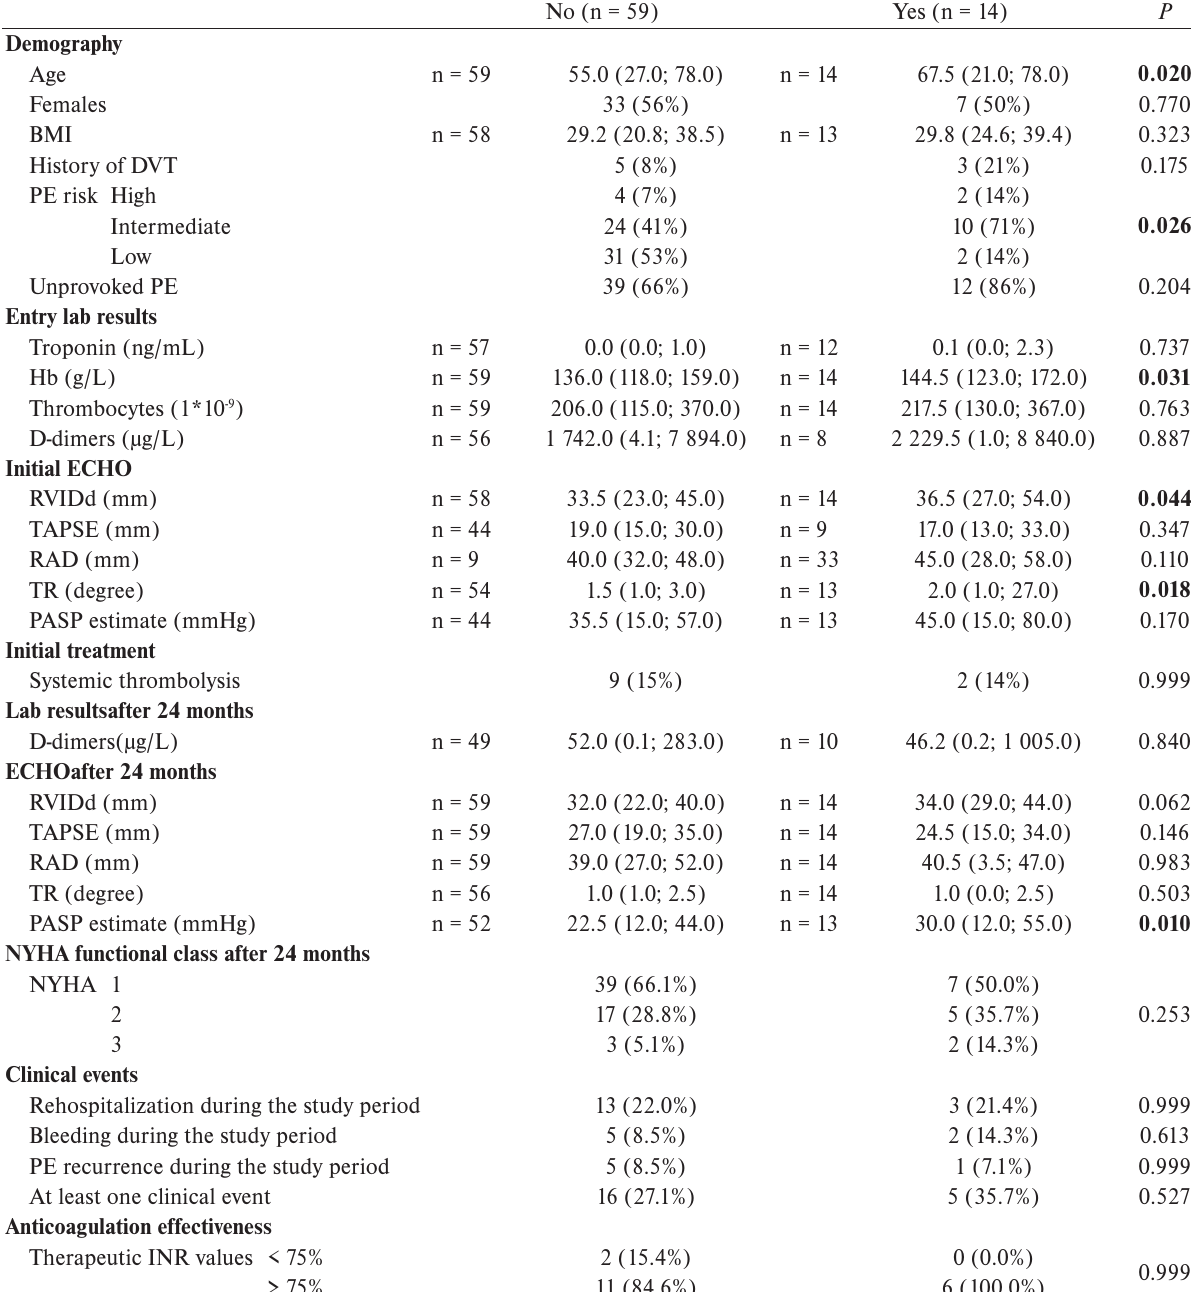
Table 3. Comparison of patients with and without persisting perfusion defects after 24